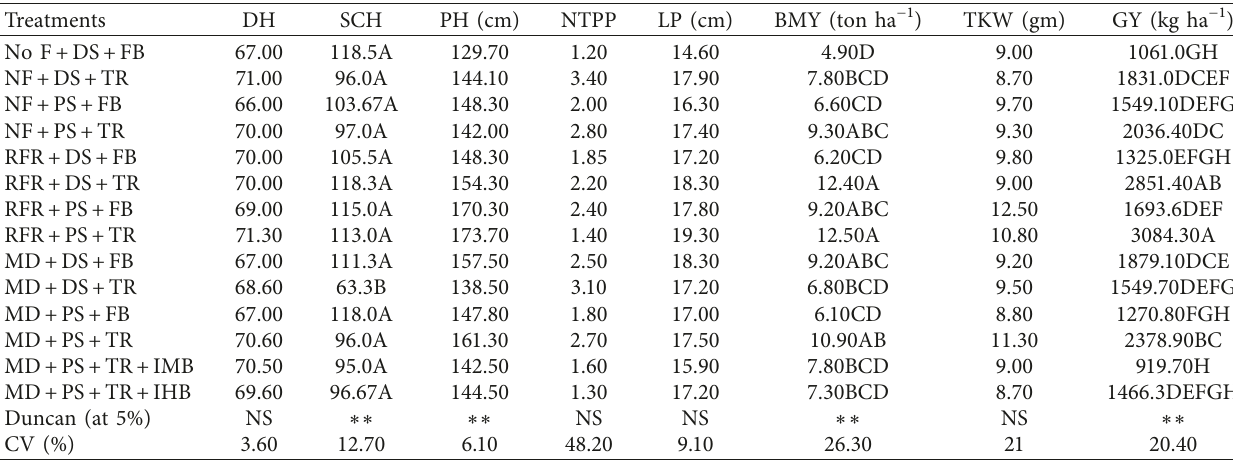
Table 2: Effect of integrated technologies on the productivity of pearl millet at Aybra in the 2013 main cropping season.